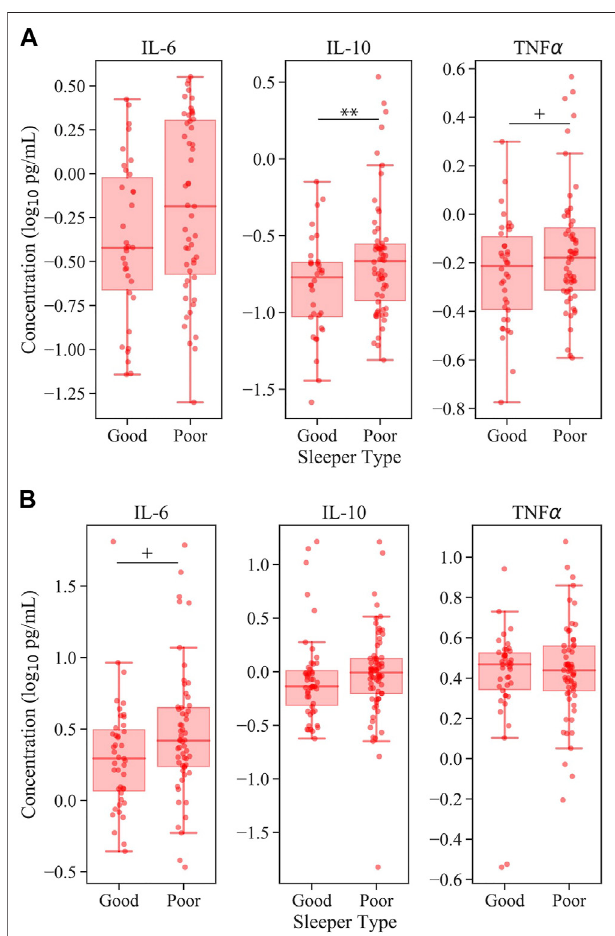
FIGURE 2 | In fl ammatory cytokine levels according to sleeper type in mTBI. Panel (A) represents EV cytokine levels and panel (B) represents plasma cytokine levels. All models control for the effects of age, sex, and BMI. For clarity, data are visualized without values below the lower limits of quanti fi cation. Note the signi fi cant elevation of EV IL-10 in mTBI patients with poor sleep. + denotes p < 0.10; ** denotes p < 0.01.